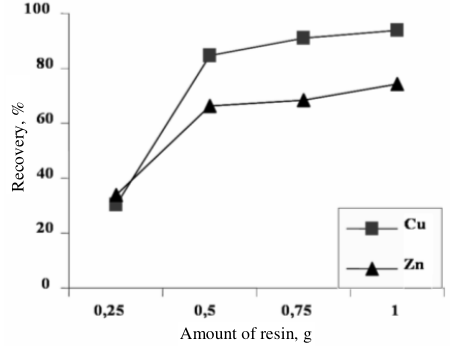
Figure 2. The effect of resin amount on the % recovery of metal